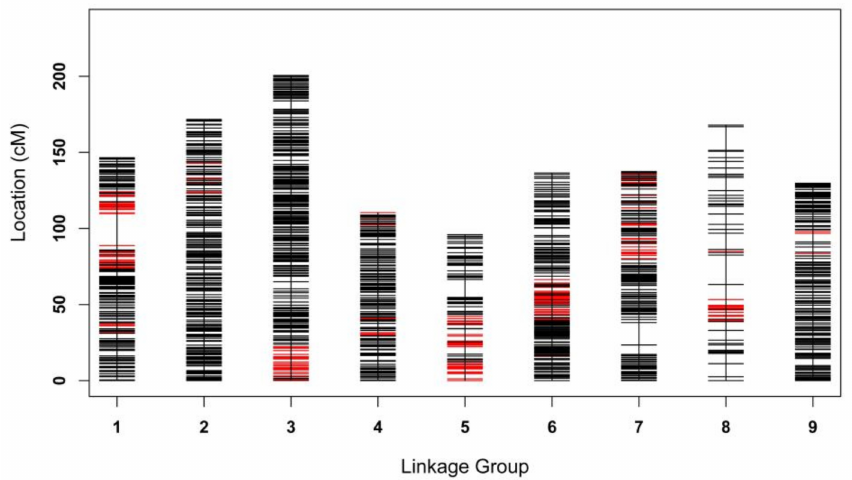
Figure 5. Distribution of all polymorphic SSR and SLAF markers in nine linkage groups. The x-axis represents each LG, the y-axis represents the genetic distance of LGs, the red line represents segregation distortion markers (0.001 < p <